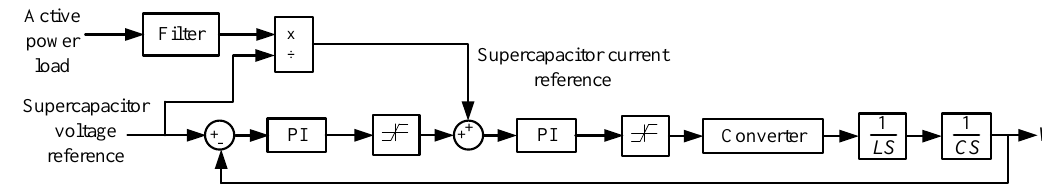
Figure 8. PI control of super capacitor in energy storage system.